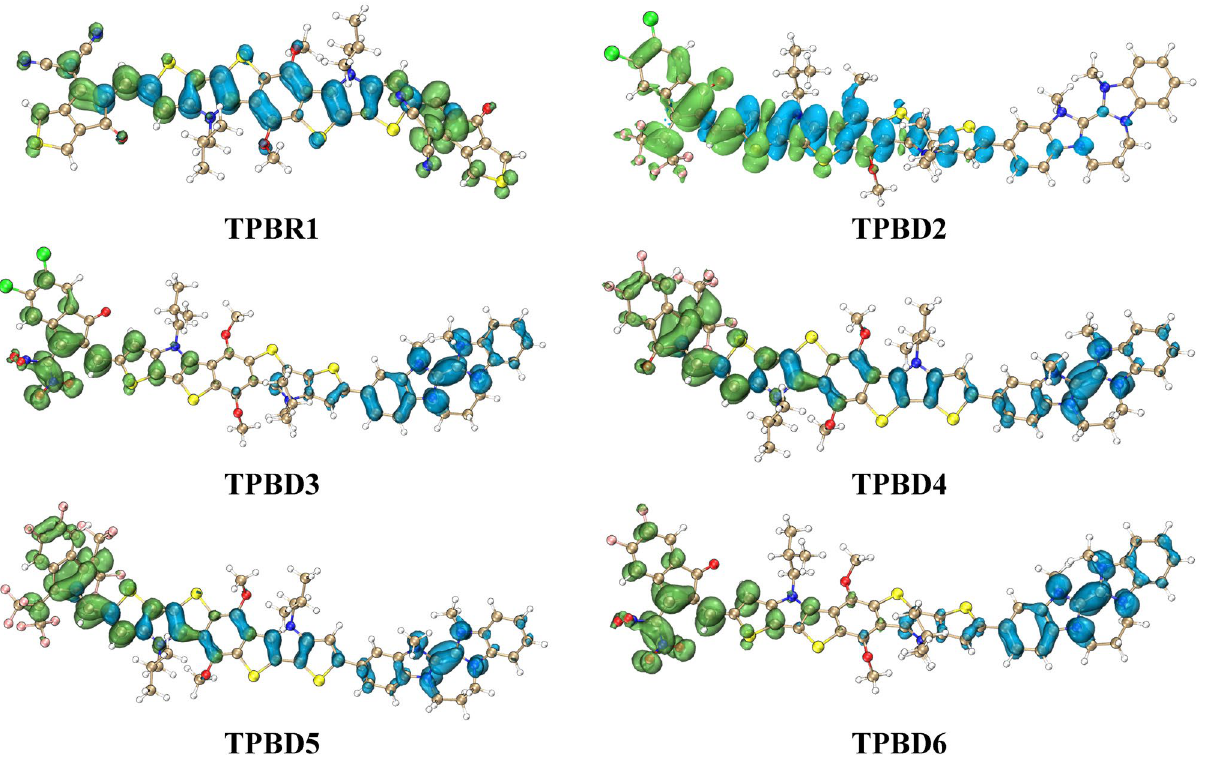
Figure 4. Hole + electron surface plot for excitation S 0 → S 1 of compound entitled chromophores. Hole is the blue surface and electron is the green surface. These surfaces are drawn by utilizing VMD software (https:// www. ks. uiuc. edu/ Resea rch/ vmd/) All out put files of entitled compounds were computed through Gaussian 09 version D.01 (https:// gauss ian. com/ g09ci